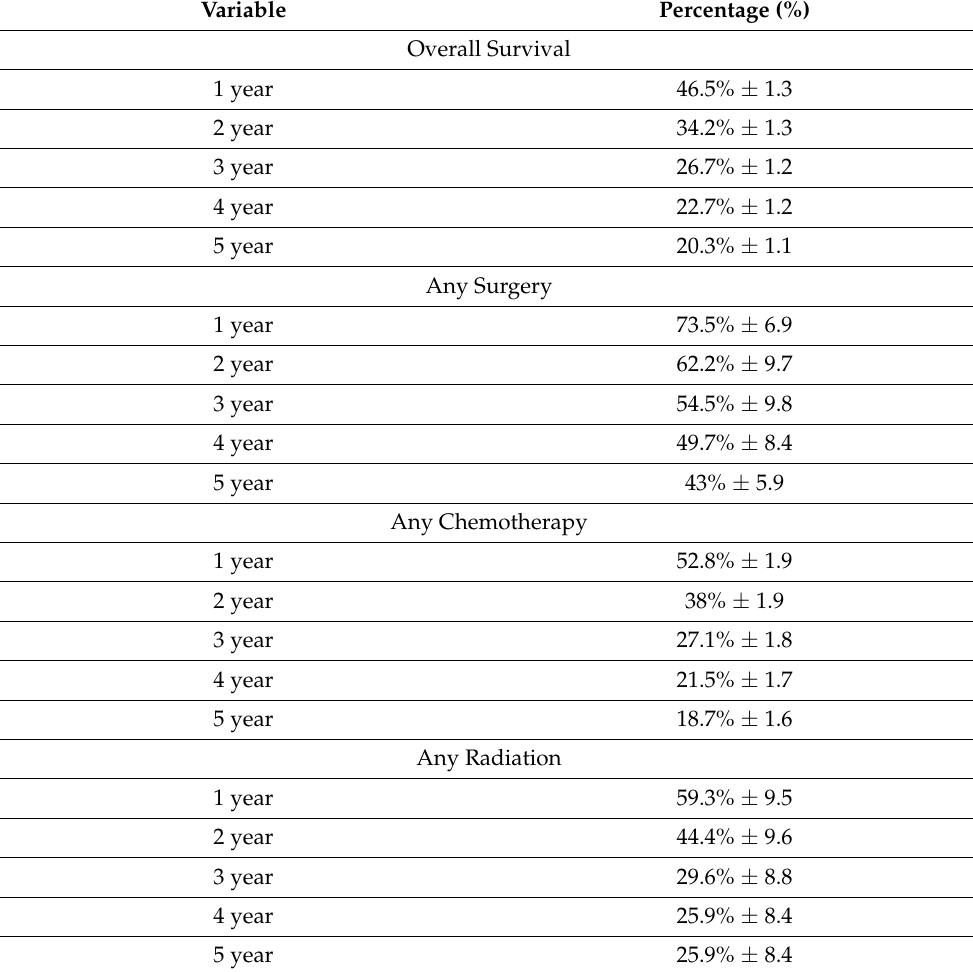
Table 5. Overall and Treatment Associated Survival Analysis of 1998 Patients with Primary Peritoneal mesothelioma from the Surveillance, Epidemiology, and End Results (SEER) database, 1975–2016. Variable